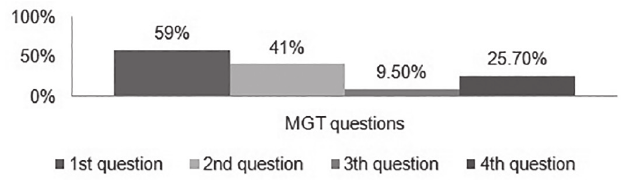
FIGURE 2 - Individual examination of the MGT (Morisky-Green test) questions, showing the percentage of negative responses obtained in the The internal consistency of the responses obtained through the MGT showed that this measuring instrument